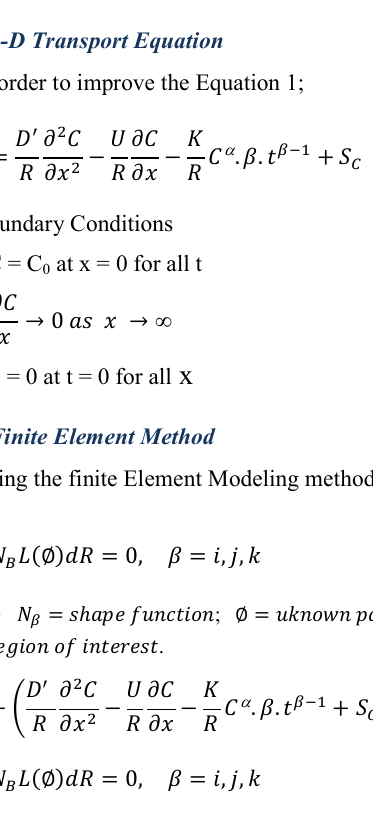
Figure 2. Flow Chart of the Research